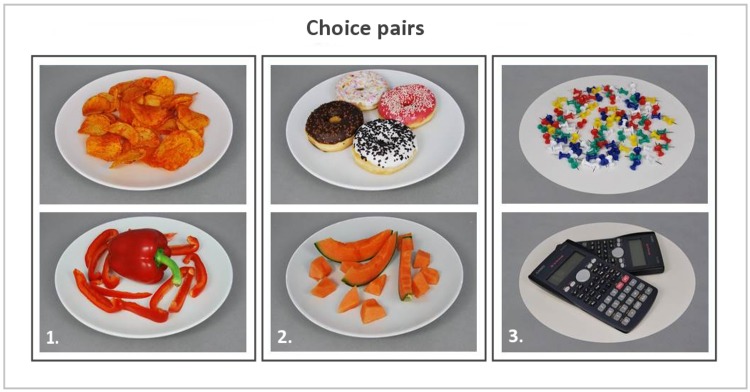
Example of choice pairs.1: High & low calorie food pair, savoury taste; 2: High & low calorie food pair, sweet taste; 3: Non-food pair.